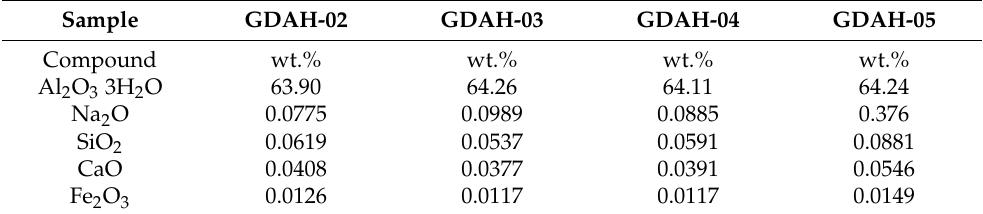
Table 2. Major metallic oxides (wt.%) identified through XRF analysis of the chemical composition of the ceramic